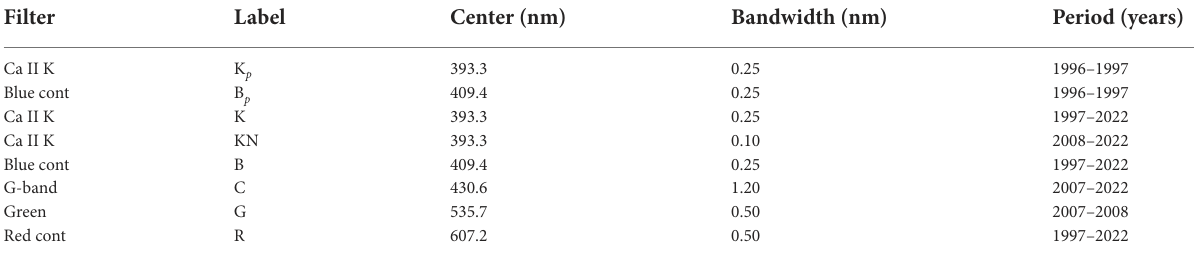
TABLE 1 InterferencefiltersinstalledintheRome/PSPT.Listedare:filternameandlabelusedtoidentifyit,nominaltransmissioncenterandbandwidth